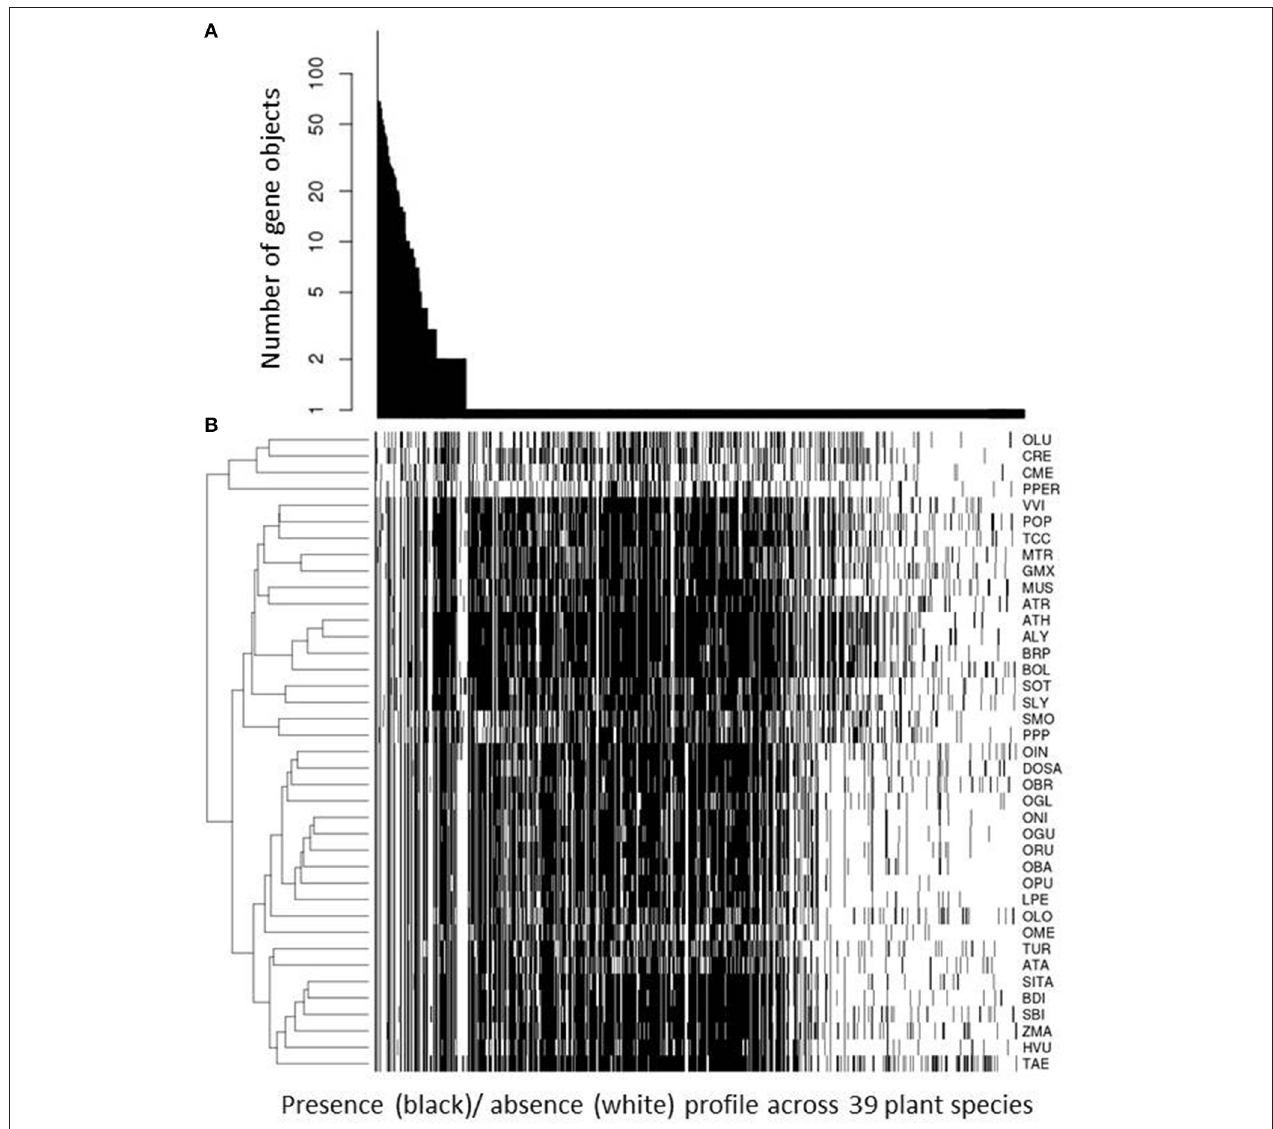
FIGURE 6 | Phylogenetic profile frequency statistic. For all 818 unique phylogenetic profiles, their respective occurrence; i.e. number of gene objects with this profile, is plotted in descending order of occurrence (A) . The associated actual presence (black cell)/ absence (white cell) for all 39 plant species considered in this study is plotted underneath (B) . Plant species are given by their abbreviation introduced in Table 1 and clustered hierarchically (complete linkage, Euclidean distance) according to similarity of presence/absence pattern. Unique profiles found for only one gene object are sorted in descending number of genes clustered into this object; i.e., from large gene families (grouped to the left) to small gene families and singleton genes (grouped to the right). Note that we used only those gene objects for which a KEGG annotation for at least one member plant was